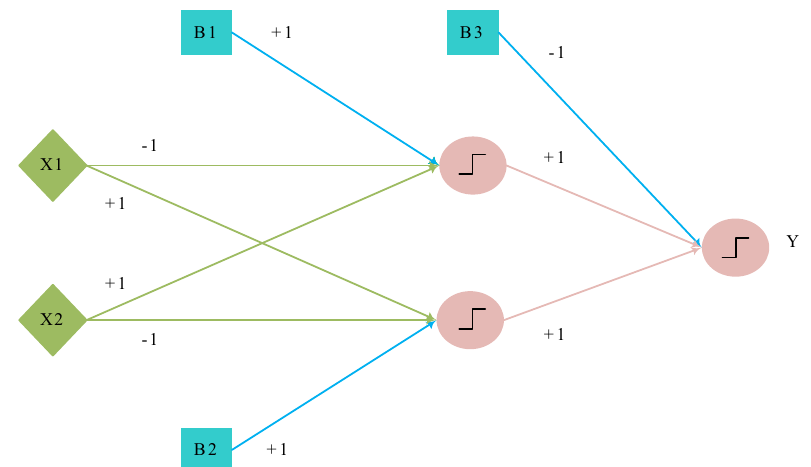
Figure 4: Schematic diagram of binary neural network.